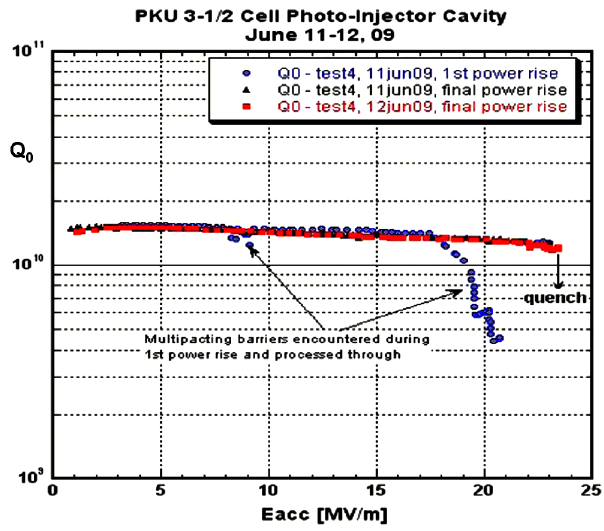
FIG. 12. Q 0 vs E acc during vertical test measurement done at TJNAF. Courtesy of Kexin Liu,